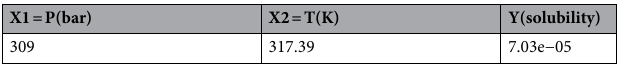
Table 3. Optimized pressure and temperature/ optimized solubility.